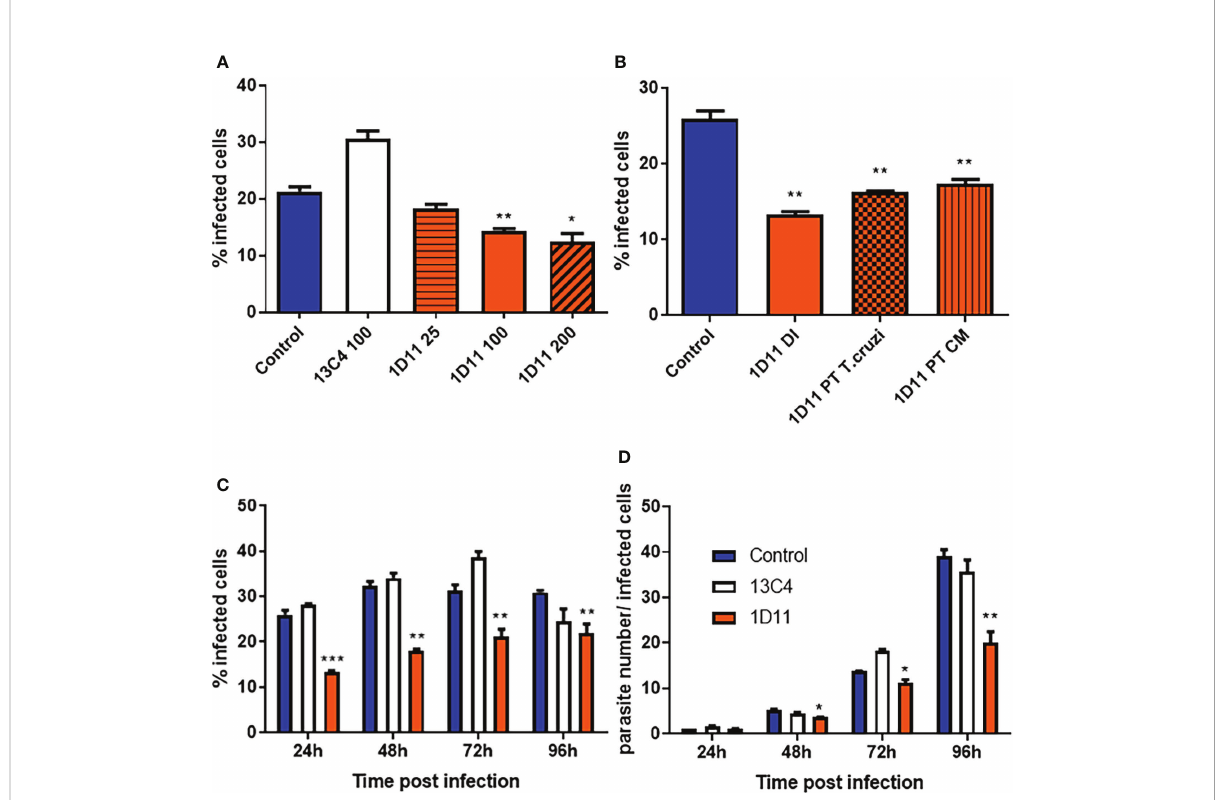
FIGURE 1 1D11 treatment decreases T. cruzi invasion of cardiomyocytes and the parasite number per infected cells. The percentage of cardiac cells containing parasites (A – C) and the number of parasites per infected cell (D) were determined by counting 400 cells/slide on two distinct coverslips at 24, 48, 72, and 96 h post infection. Data are means ± standard deviations from three independent experiments. Signi fi cant differences between infected cells treated or not with 1D11 are indicated by *p < 0.05 **p< 0.01, ***p<